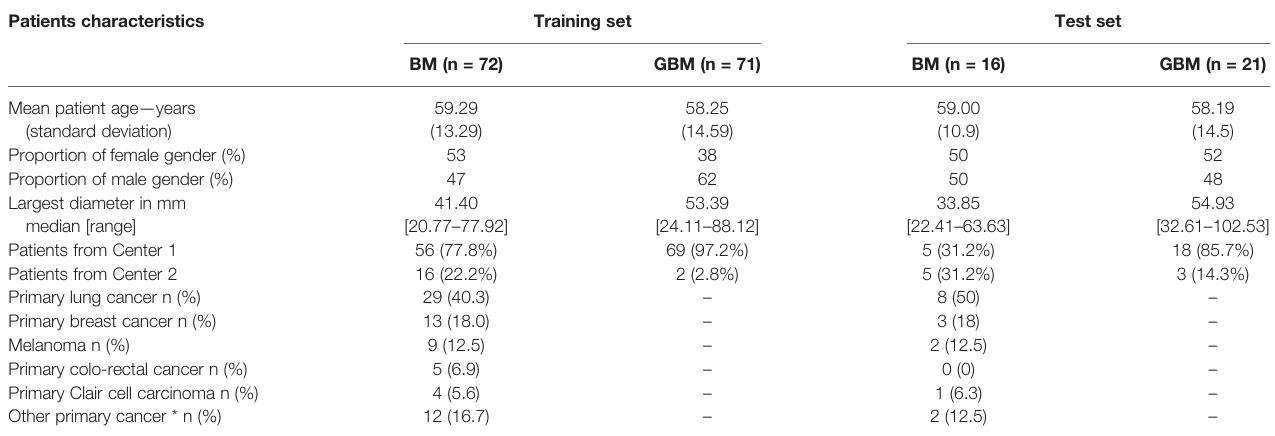
TABLE 1 | Demographics and clinical characteristics at diagnosis of the patients included in the training set and in the test set. Patients